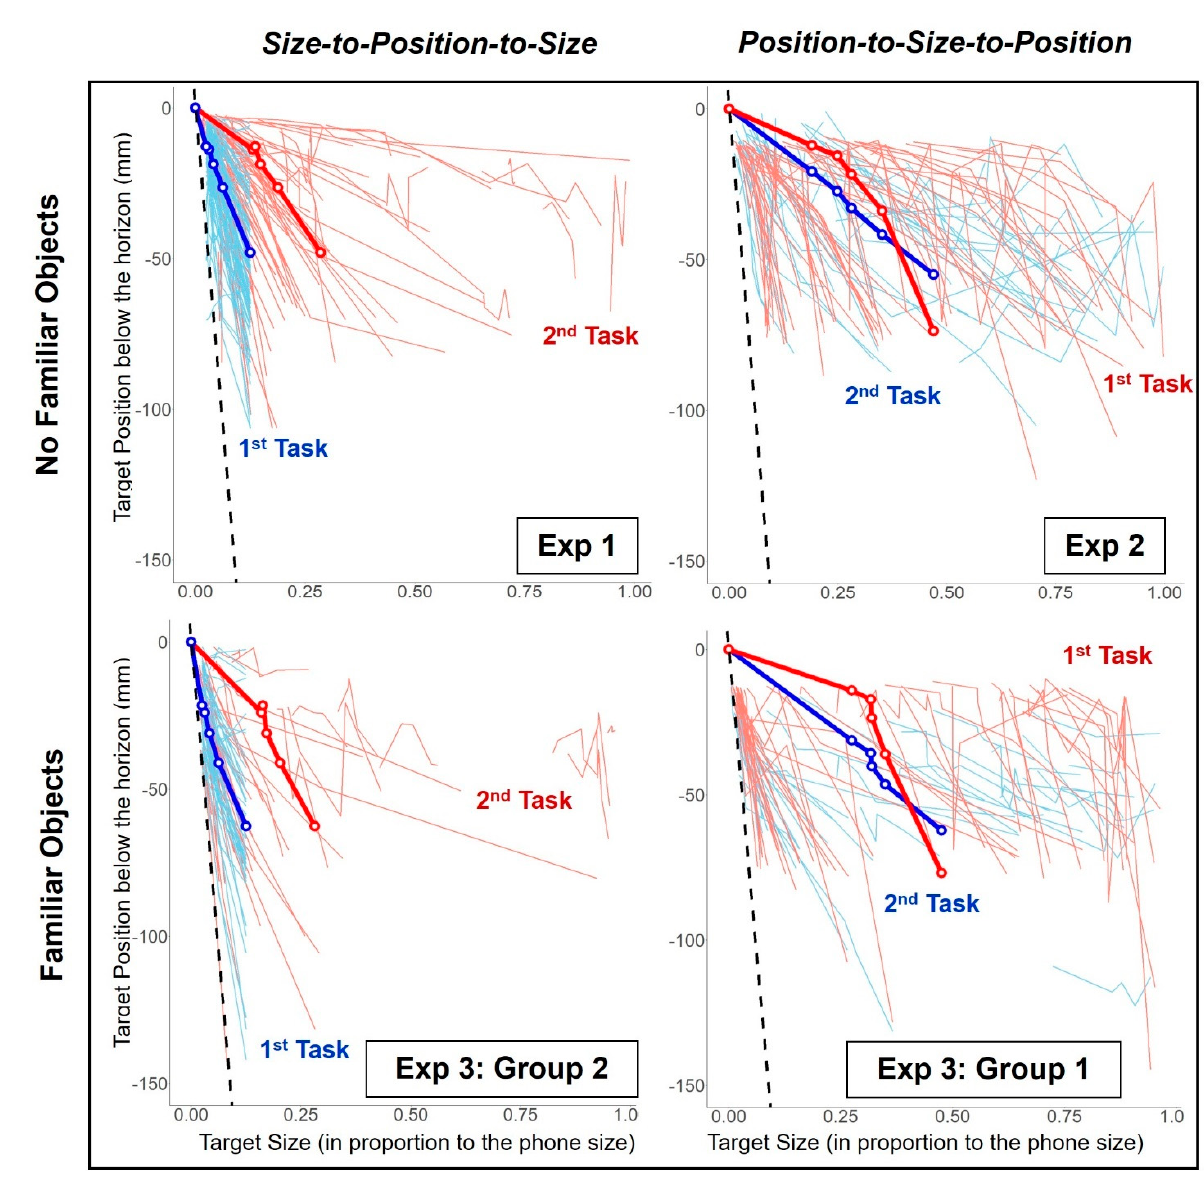
Figure 7. Participants’ settings for all tasks. Target position plotted as a function of target size. Top row, with no familiar objects ( Exp 1 and Exp 2 ); bottom row, with familiar objects ( Exp 3 ). Left column, the Size-to-Position task first followed by the Position-to-Size task; right column, the Position-to-Size task first followed by the Size-to-Position task. The dashed black lines represent target sizes and positions with the correct geometry. The solid light-colored lines are the average responses from each individual participant and the darker-colored lines with white dots represent the mean of responses from all participants for each task, where the dots are the means for each simulated target: the Size-to-Position task ( Blue ) and the Position-to-Size task ( Red ). (The means and the standard errors can be found in Table 1).